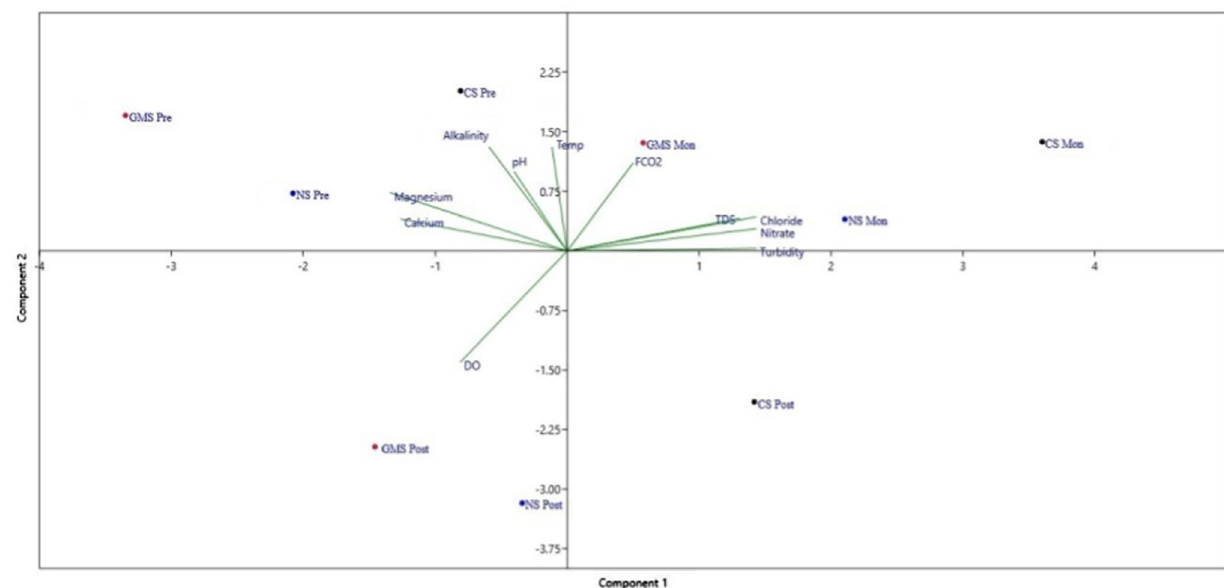
Fig. 6 PCA scatterplot for the first two components showing the relationship between physicochemical parameters in different sites and